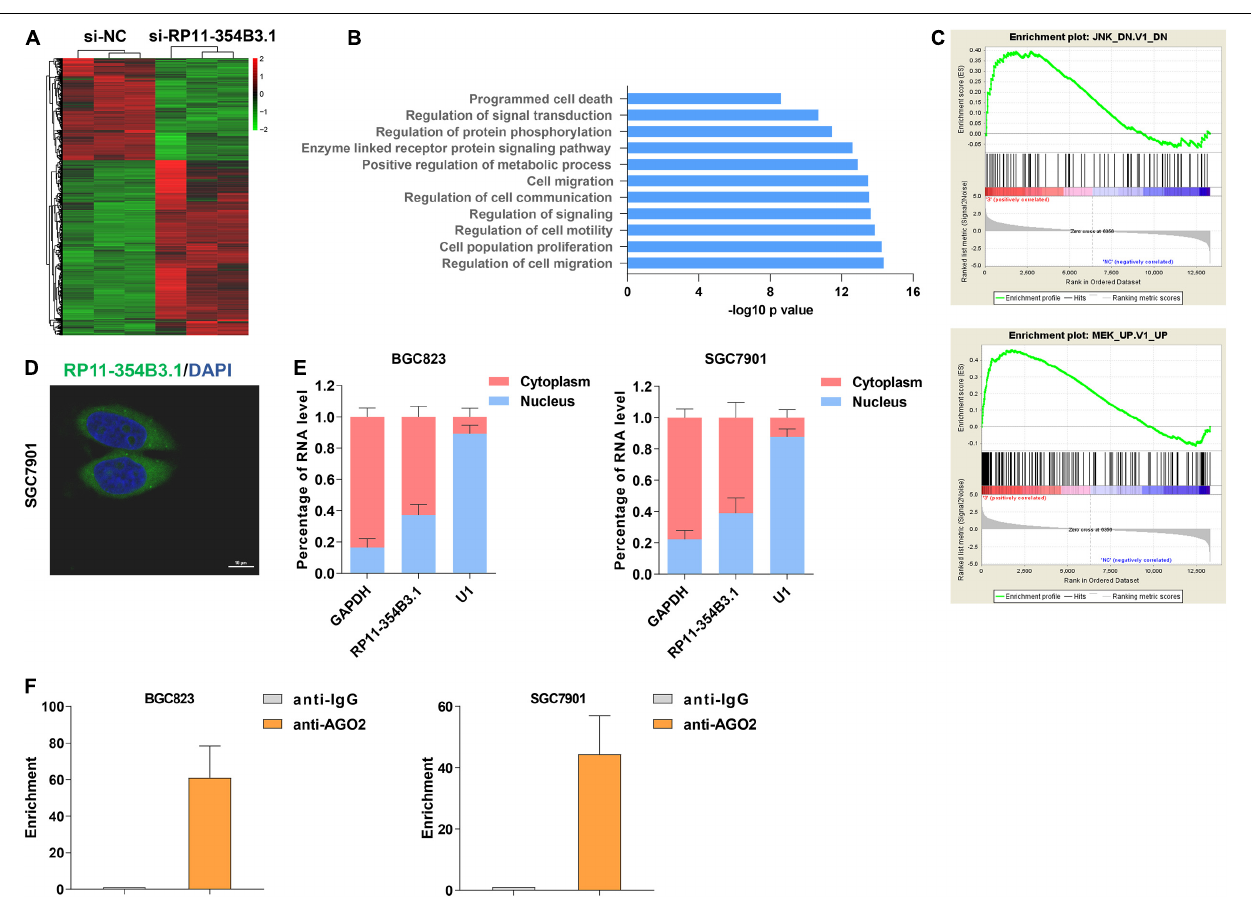
FIGURE 4 | Downstream regulation mechanism of RP11-354B3.1 in gastric cancer. (A) A heatmap was drawn to show the differentially expressed genes in RP11-354B3.1 depleted cells. (B) GO pathway analysis of RP11-354B3.1 regulated genes enriched cellular process and pathways. (C) GSEA analysis shows the enrichment of RP11-354B3.1 regulated genes in JNK and MEK targets list. (D) FISH analysis of the subcellular localization of RP11-354B3.1 in SGC7901 cells. (E) RP11-354B3.1 expression levels in different subcellular fractions in BGC823 and SGC7901 cell lines. (F) RIP with anti-AGO2 and IgG from BGC823 and SGC7901 cell extracts. RNA levels in immunoprecipitates were detected by qPCR. Expression levels of RP11-354B3.1 RNA are presented as fold enrichment in AGO2 relative to IgG immunoprecipitates. All experiments were performed in three independent